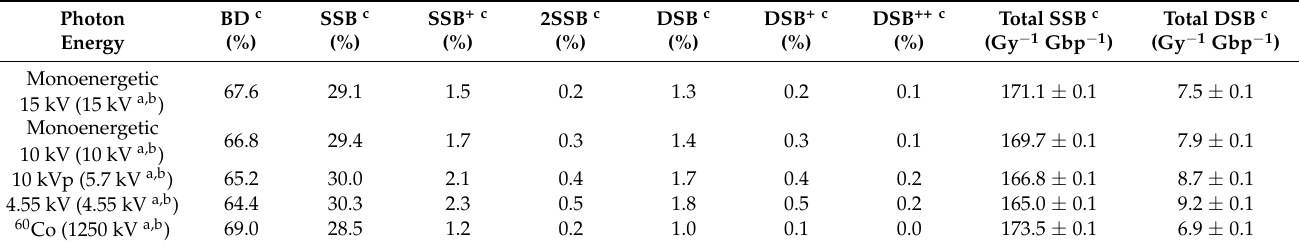
Table 4. Relative yield of DNA damage and absolute yield of DSB and SSB (per Gy per Gbp) (mean ± standard error) at a hypoxic oxygen concentration of 2%).